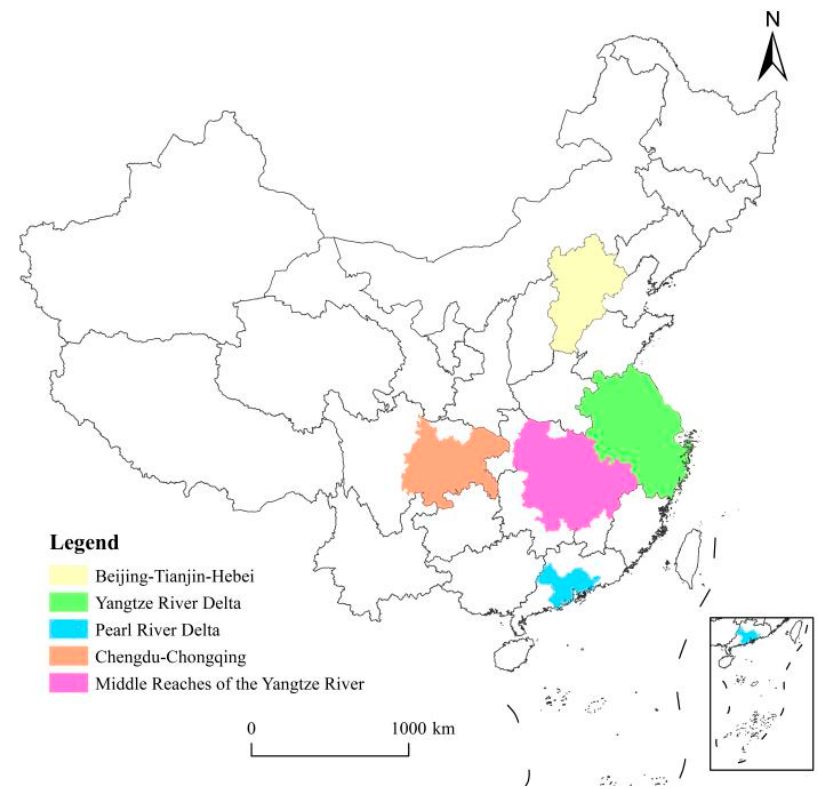
Figure 4. The distribution of five urban agglomerations in China.